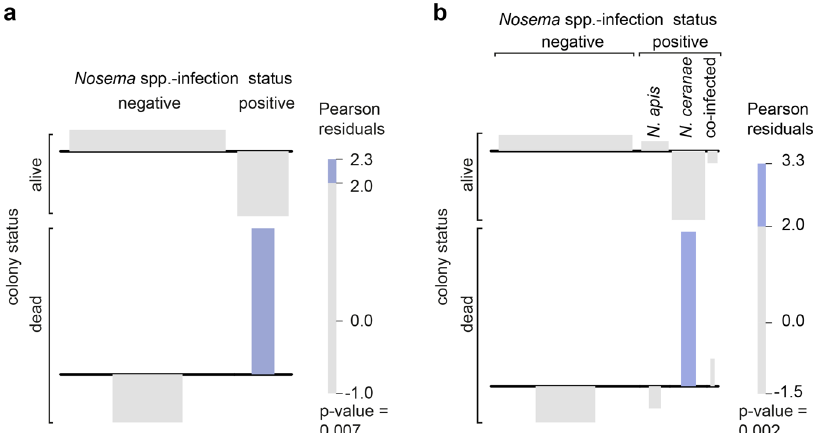
Fig. 4 Contingency table analysis. Association plots based on Chi-squared testing show the association between a Nosema spp.-infection and colony mortality and b N. apis -, N. ceranae and co-infections and colony mortality. Overrepresented entries (dead/positive in a or dead/ N. ceranae in b ) are shown in blue, non-overrepresented entries